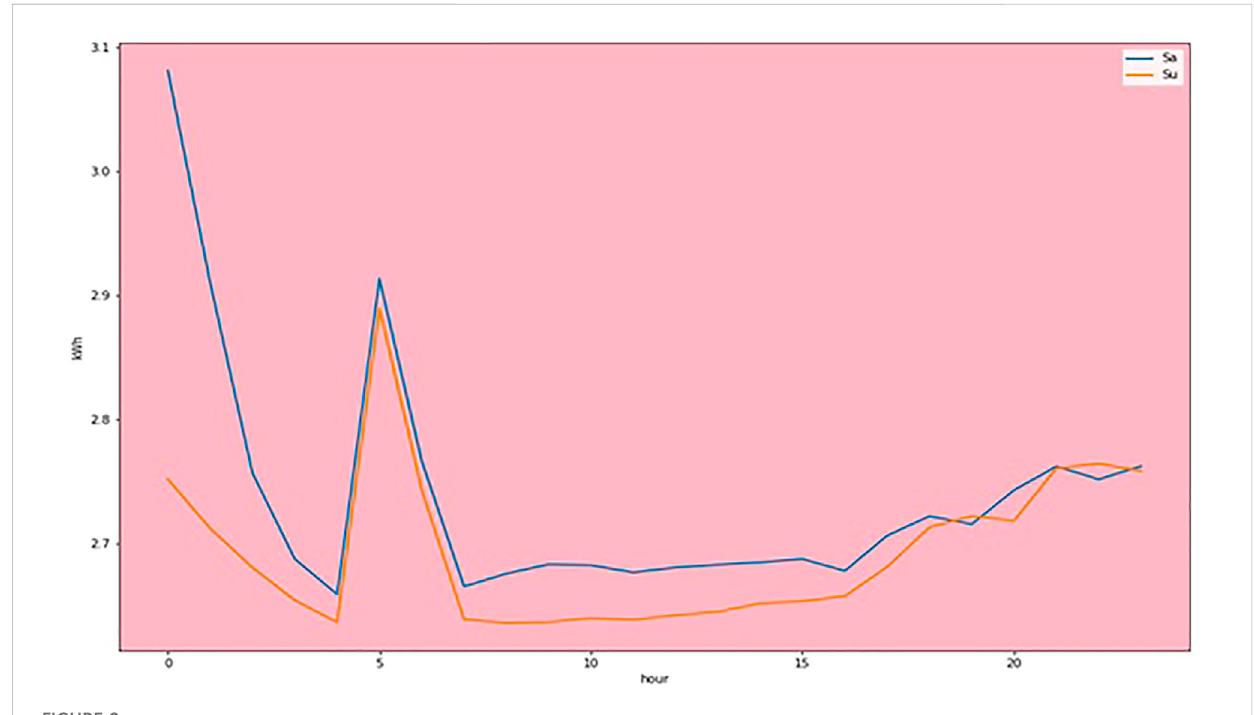
FIGURE 2 Energy consumption in KWh during weekends.